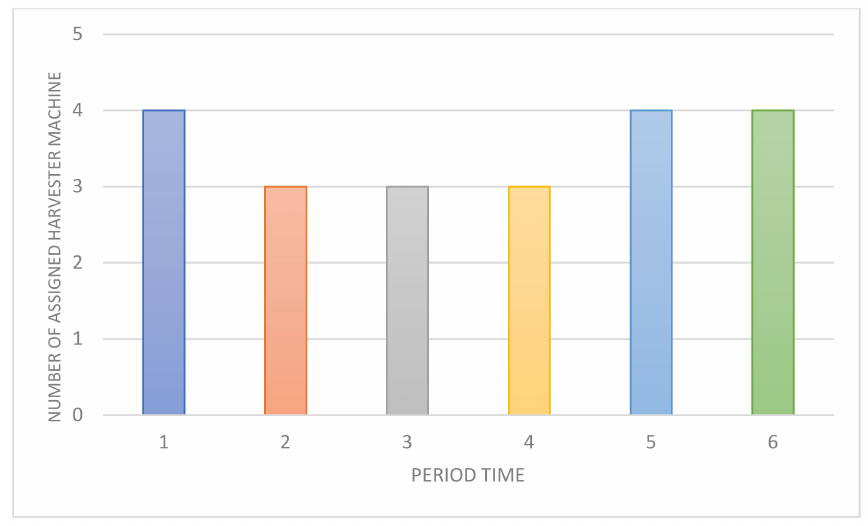
Figure 7. Optimal solution of harvester machine assignment to harvest site in each period